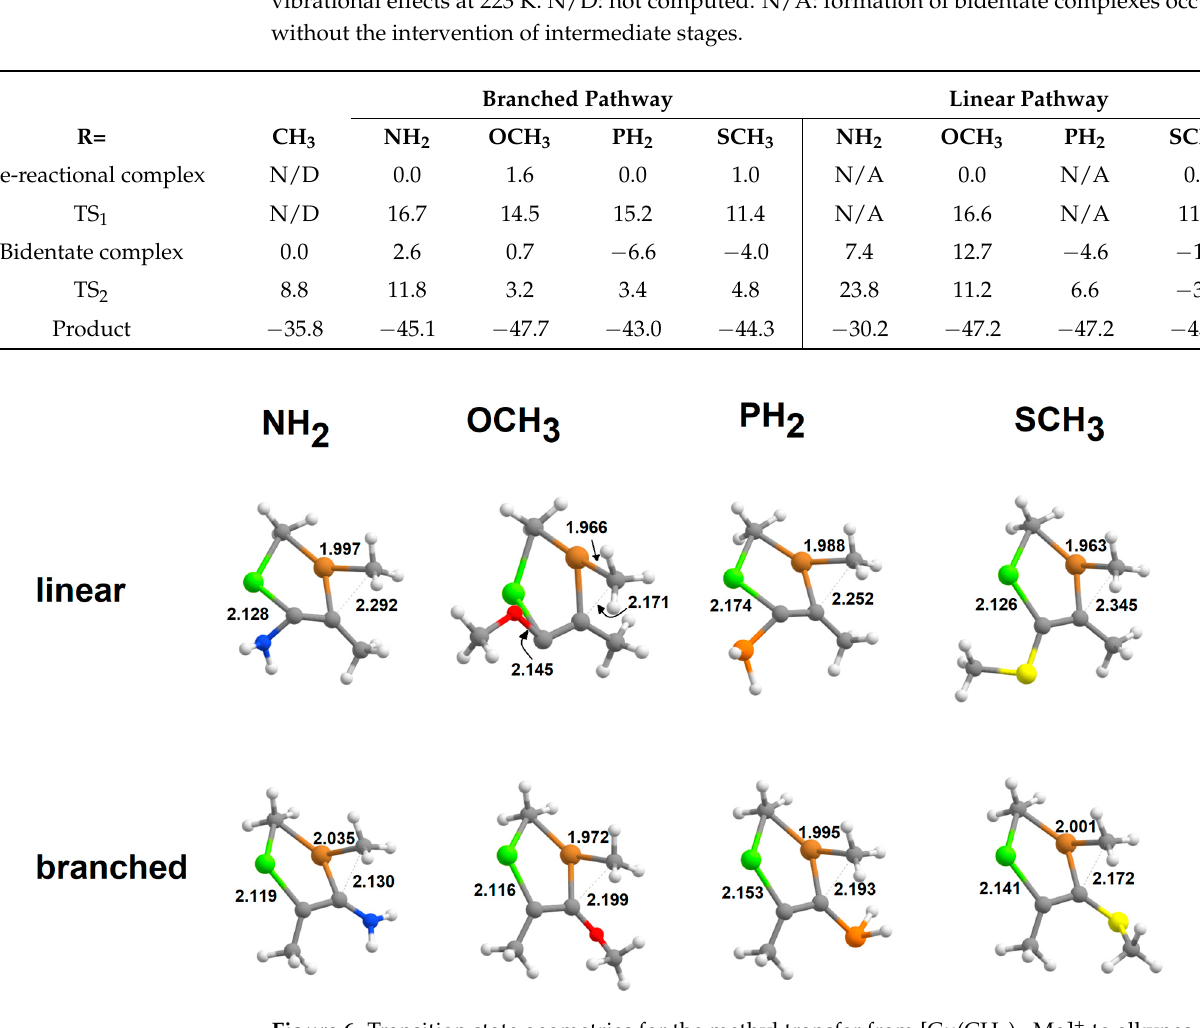
Figure 6. Transition state geometries for the methyl transfer from [Cu(CH 3 ) 2 · Mg] + to alkynes of the form R-C ≡ C-CH 3 .